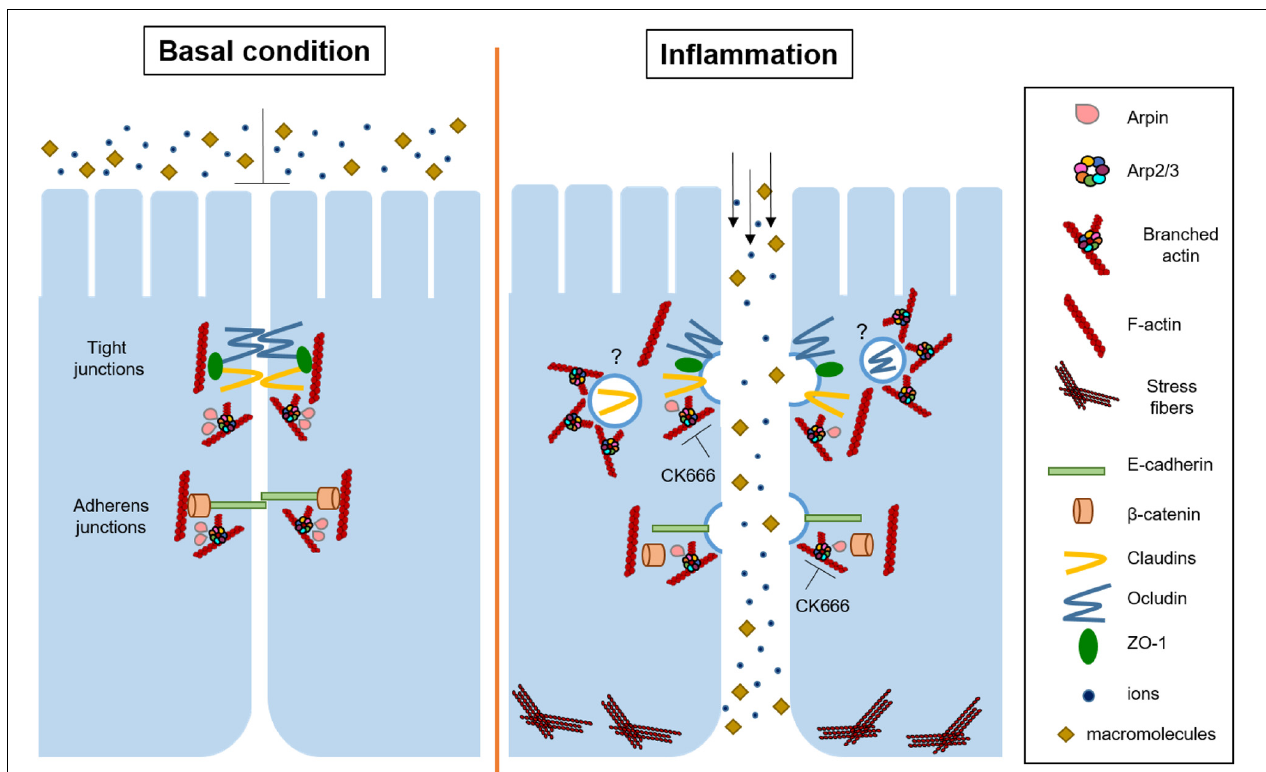
FIGURE 7 | Current working model for arpin functions and Arp2/3 inhibition in intestinal epithelial cells. Under basal conditions, arpin localizes at cell junctions to maintain Arp2/3 activity low and prevent junction protein internalization. During inflammation, arpin is downregulated, allowing for Arp2/3 activation, junction protein internalization, stress fiber formation, and thus barrier dysfunction. On the other hand, CK666 strengthens the epithelial barrier and protects from inflammation-induced barrier dysfunction by preventing Arp2/3-dependent junction protein internalization. Question marks indicate that the exact mechanism of internalization is still